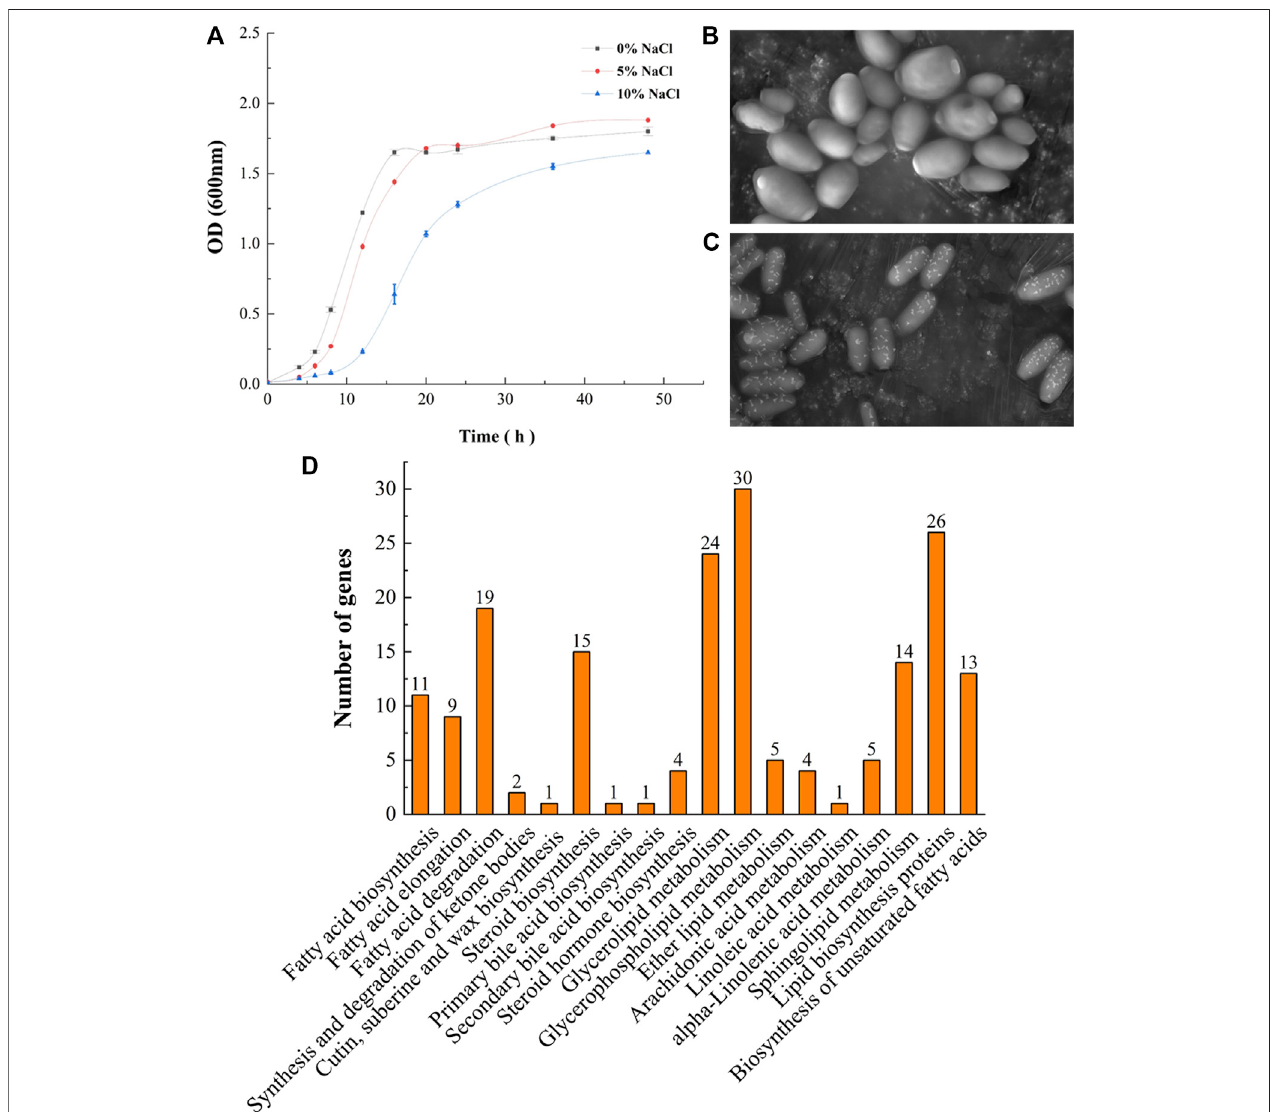
FIGURE 1 | Growth of GXDK6 under NaCl stress. (A) Growth curve of GXDK6 under different NaCl stresses; (B) morphology of GXDK6 under 0% NaCl; (C) morphology of GXDK6 under 10% NaCl; (D) Gene enrichment analysis of lipid metabolism.